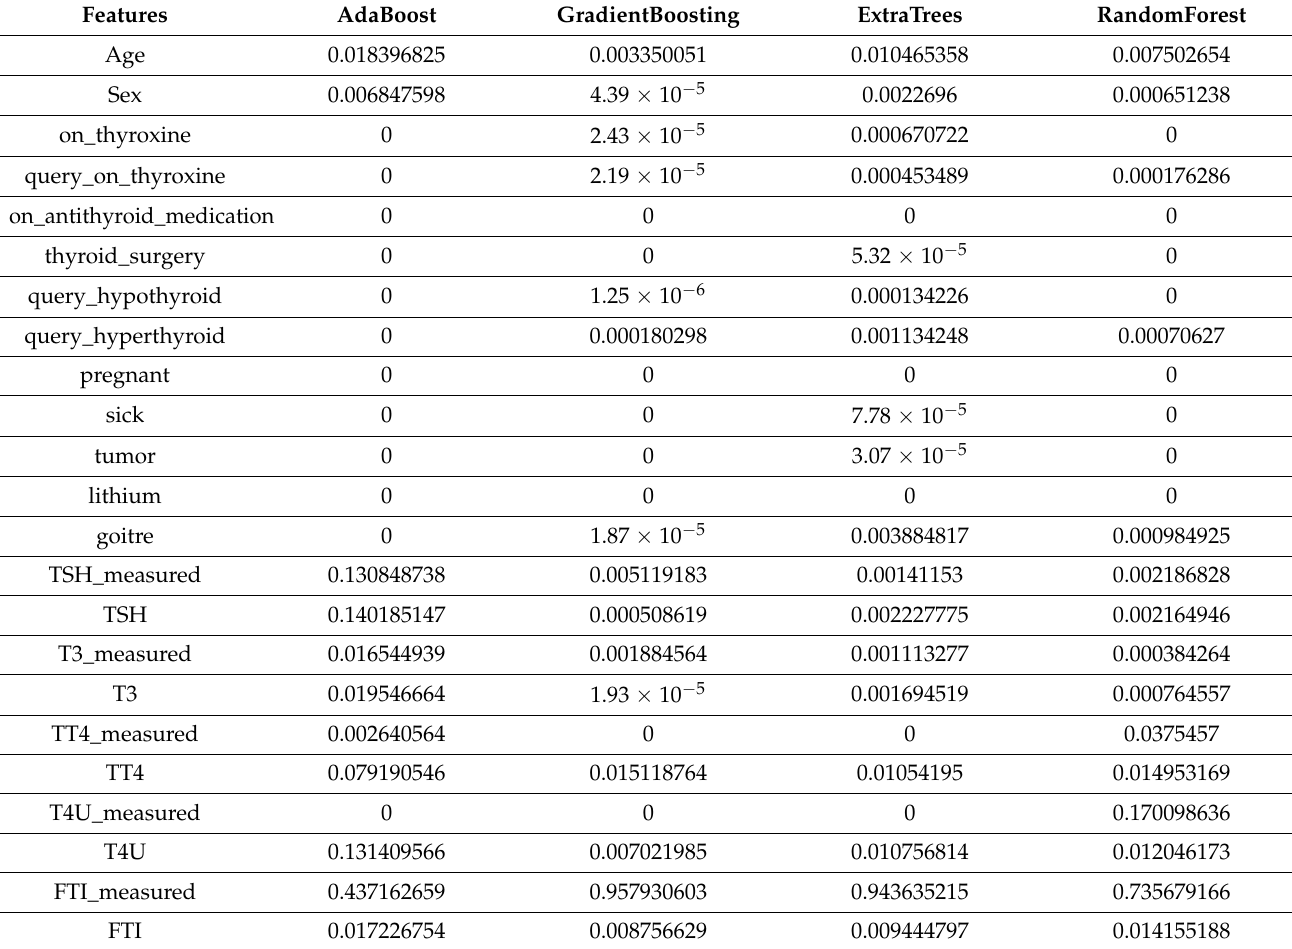
Table 5. Regressor Feature Importance Values of Each Features after Feature